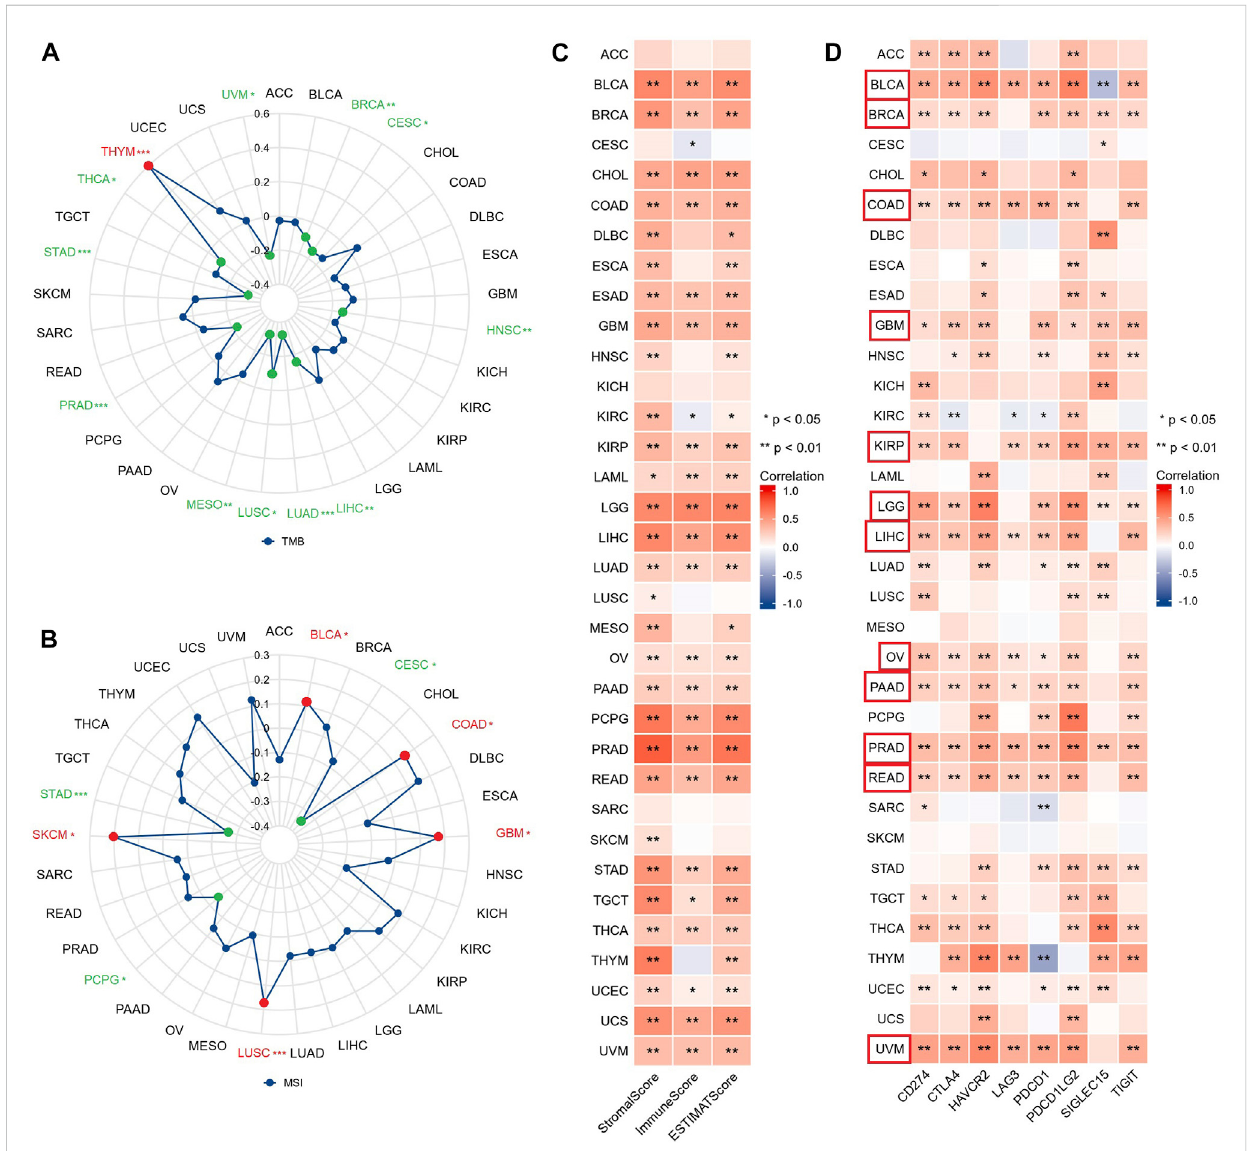
FIGURE 10 GSN expressionis associated with TMB, MSI, TME, and immunecheckpoints in 33 cancer types. Relationship between GSN expression and TMB (A) , MSI (B) in 33 cancers. (C) Relationship between GSN expression and StromalScore, ImmuneScore, and ESTIMATEScore in 33 cancers. (D) Relationship between GSN expression and immune checkpoint expression in 33